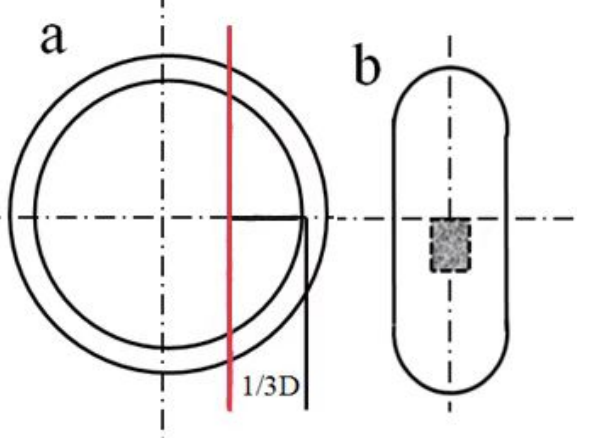
Figure 2. Microstructure sampling and observation location. ( a ) Vertical view of the sample after compression; the sample was cut along the red line. ( b ) Central position of the